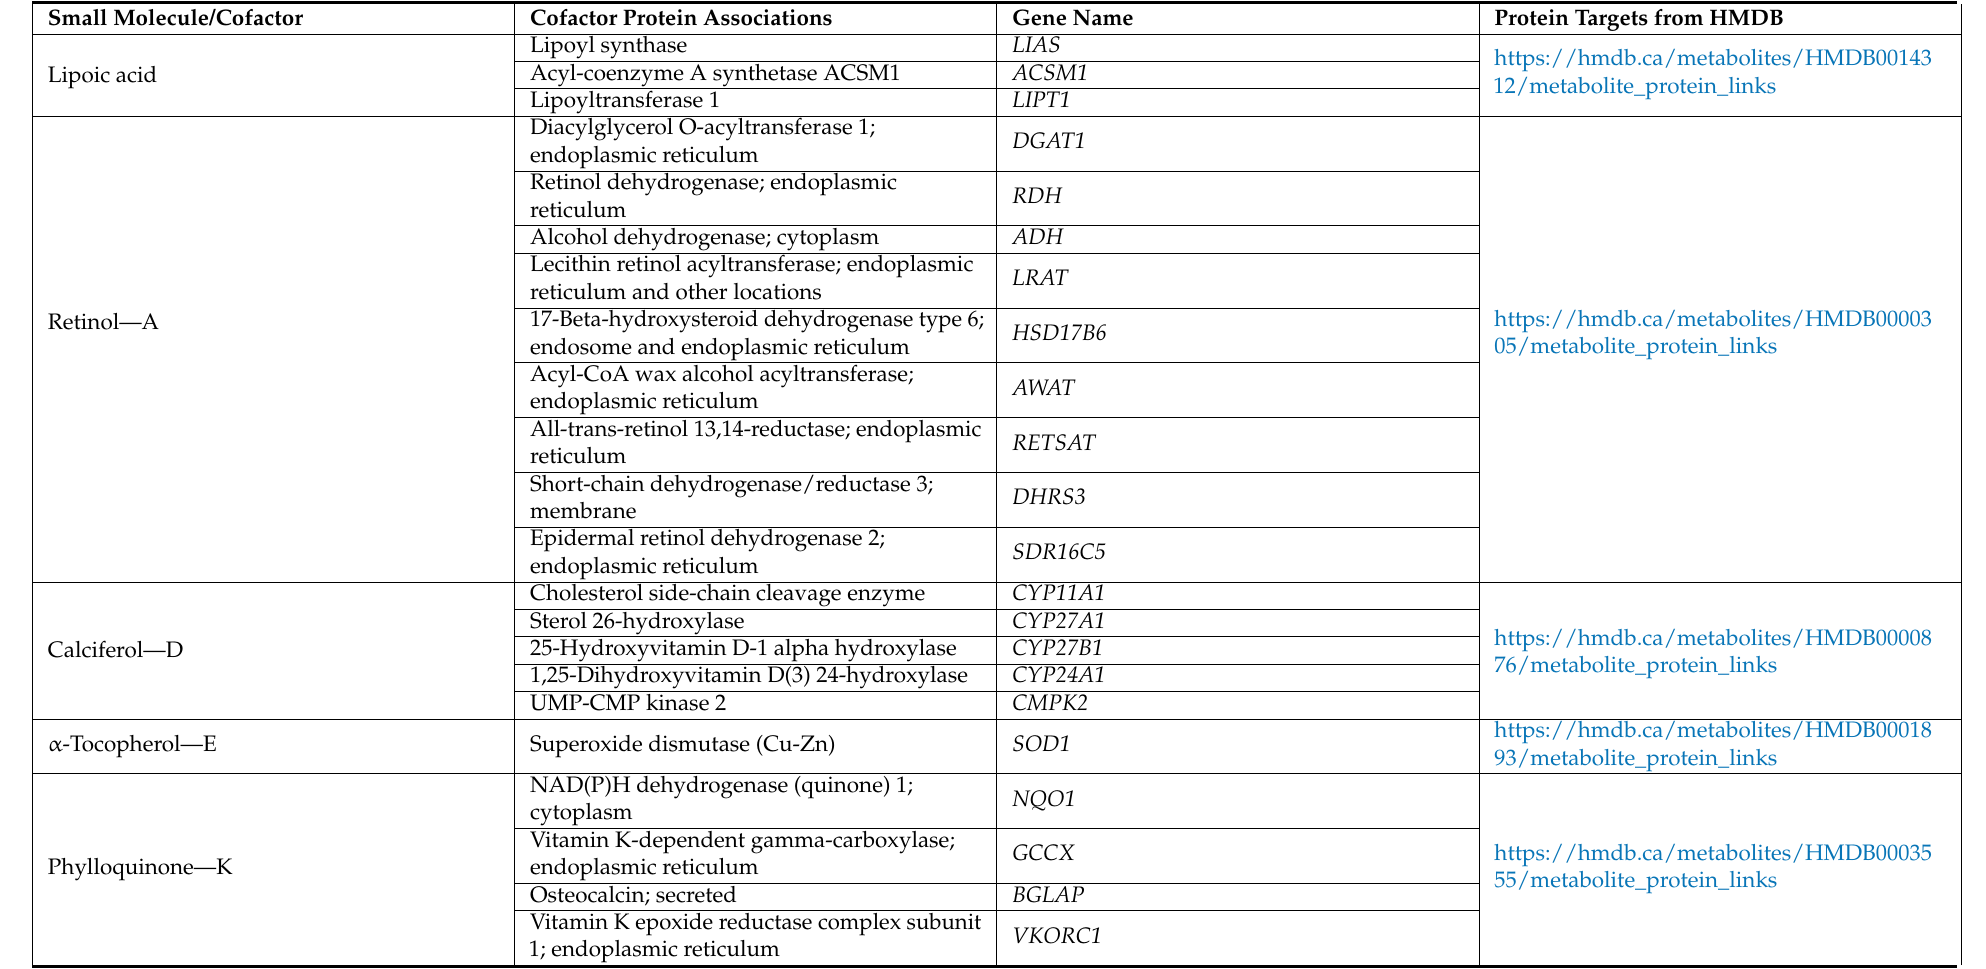
Table 4. List of the main mitochondrial/cytosolic proteins involved in interactions with the reported lipophilic vitamin-related cofactors. All the indicated web-links were accessed on 8 April 2022 for a final